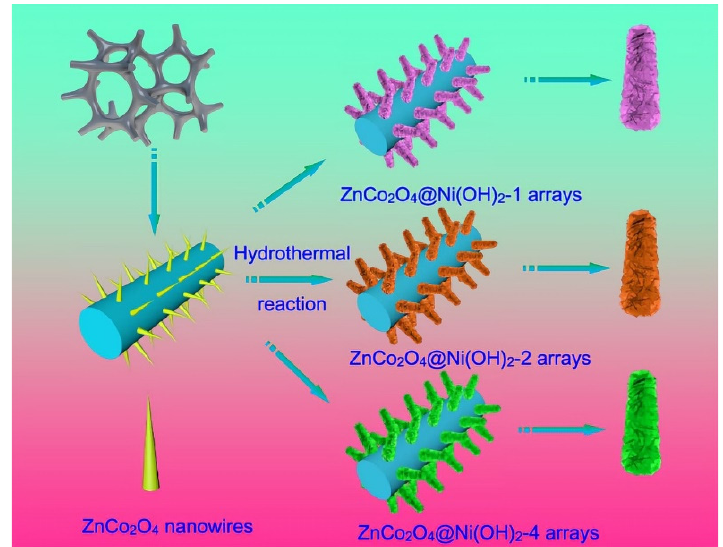
Figure 10. Synthesis schematic of synthesized ZnCo 2 O 4 @Ni(OH) 2 samples. Reproduced with per- mission from Meizhen Dai, Ni Foam Substrates Modified with a ZnCo 2 O 4 Nanowire-Coated Ni(OH) 2 Nanosheet Electrode for Hybrid Capacitors and Electrocatalysts; published by ACS Publications, 2021